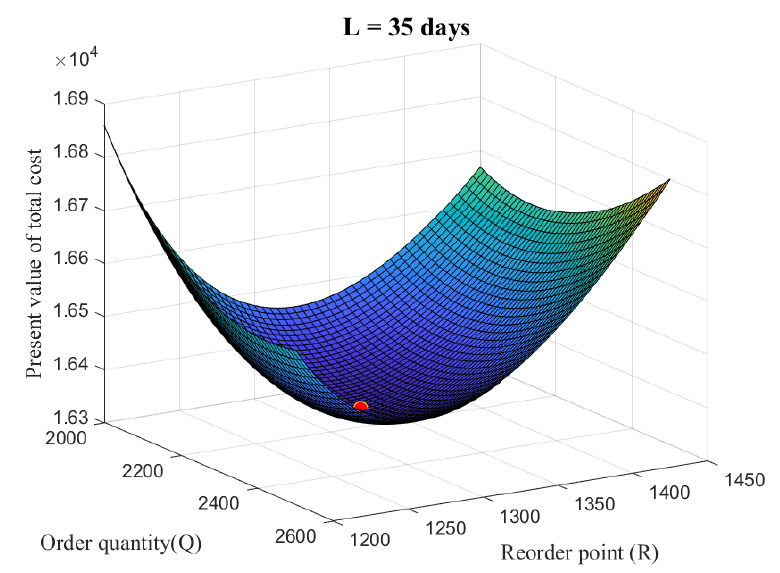
Figure 6. Plot of the total cost function for the stochastic model.